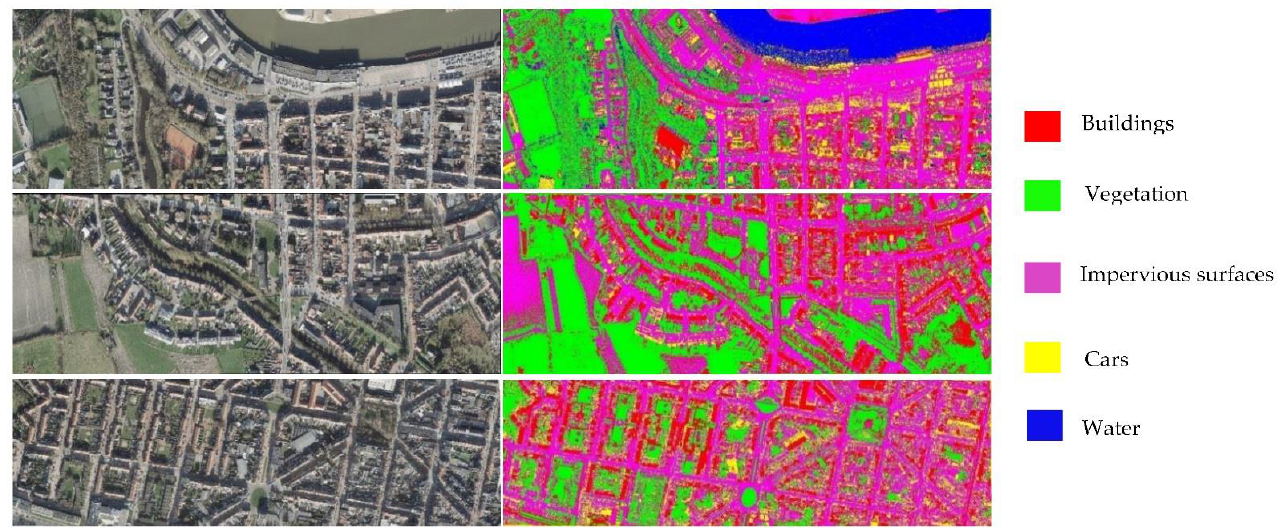
Figure 6. Examples of image classification results.